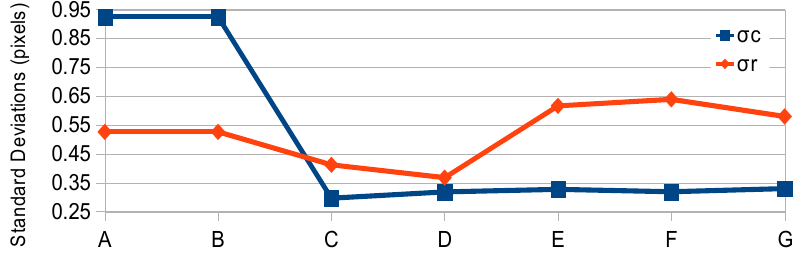
Figure 10. Average values for the standard deviations of discrepancies in tie points coordinates of five rectified image pairs with different sets of IOP and ROP, after scale change in the right